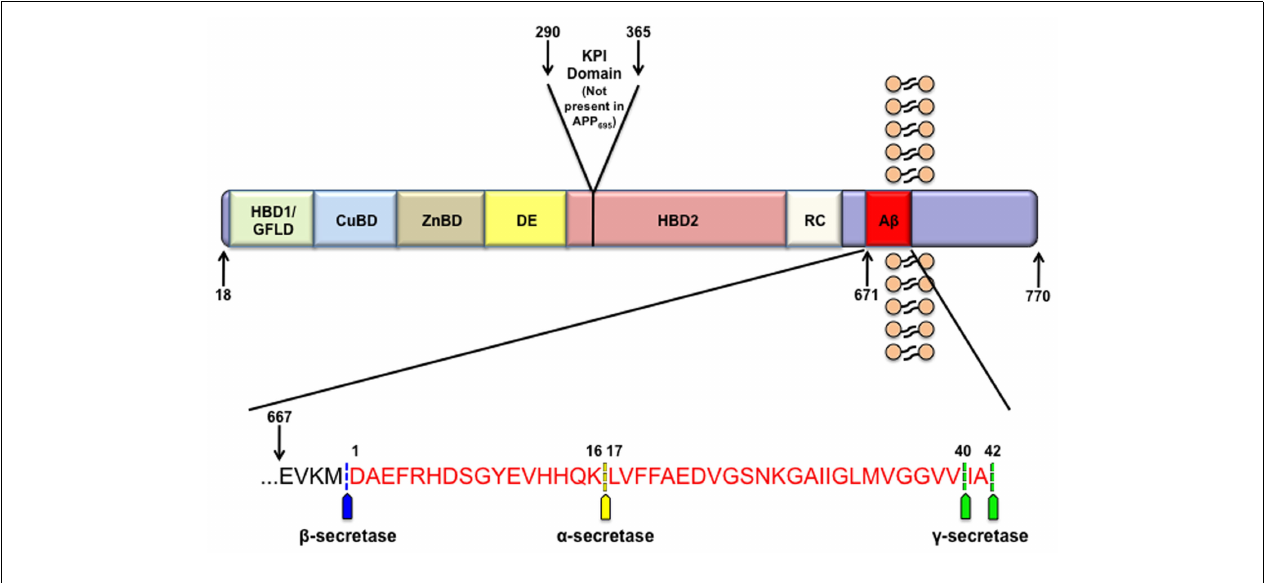
an acidic region (DE), Kunitz-type protease inhibitor domain (KPI; not present in APP 695 ), a second heparin binding domain (HBD2), random coiled region (RC), and the amyloid beta domain (A β ).The inset displays the human amyloid beta sequence in red along with the sites of APP cleavage by α -, β -, and γ